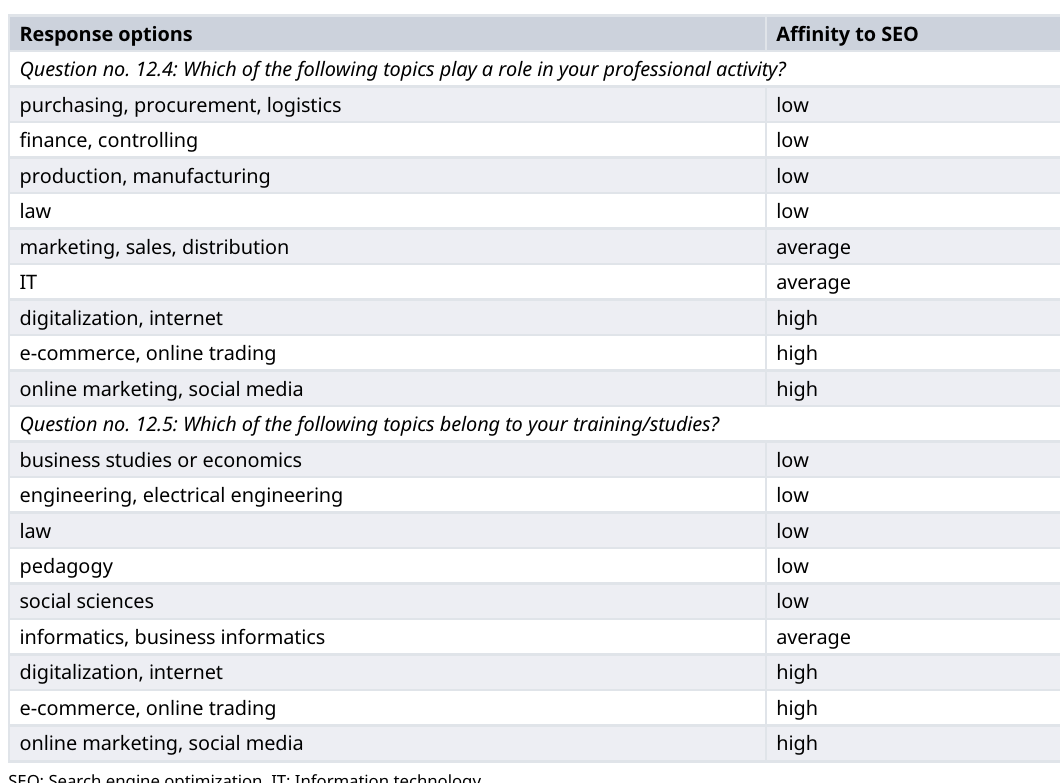
Table 4. Affinity to SEO topics (grouping).